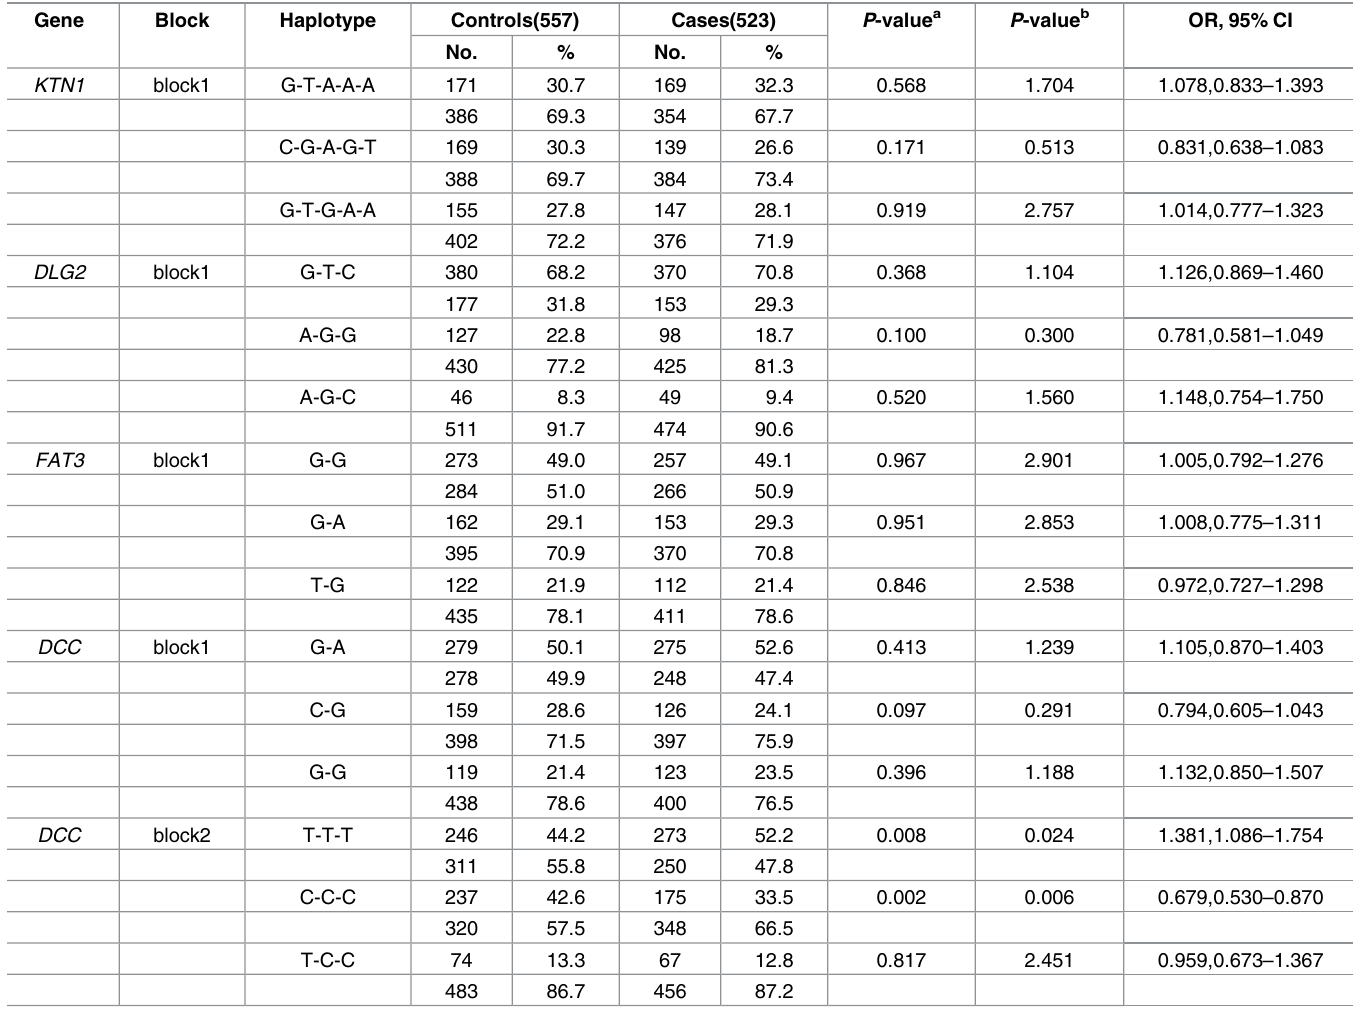
Table 2. The frequencies of haplotypes in the four genes and their associations with the risk of heroin addiction. Gene Block